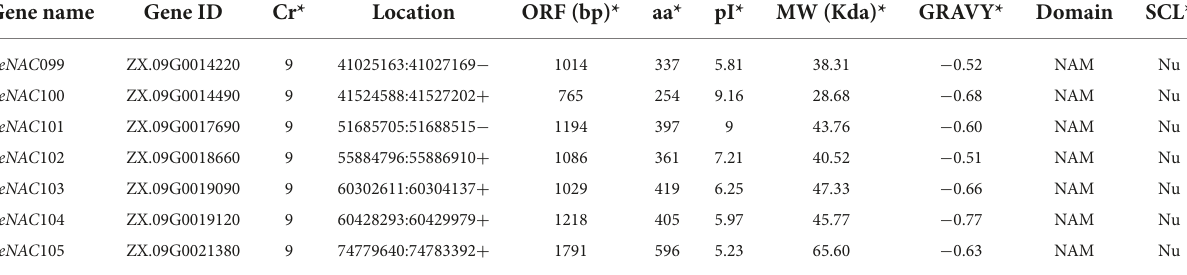
Figure 2B ). Motif prediction results revealed that the highly conserved PeNAC members may have similar motif information and that the N -terminal motif contains A-E subdomains that confer DNA-binding activity ( Figure 2B